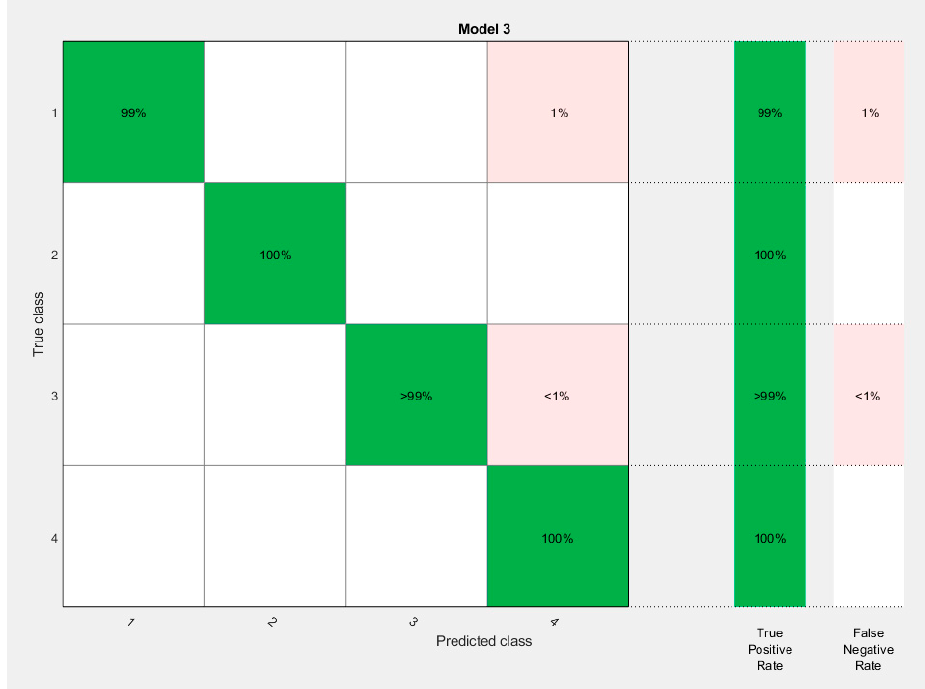
Figure 19. ANN-classifier learning result. Confusion matrix.